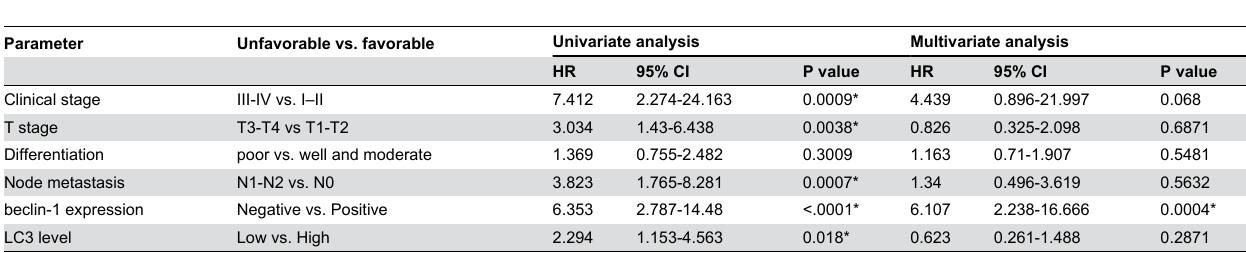
Table 4. Results of univariate and multivariate Cox regression analyses in 82 patients a